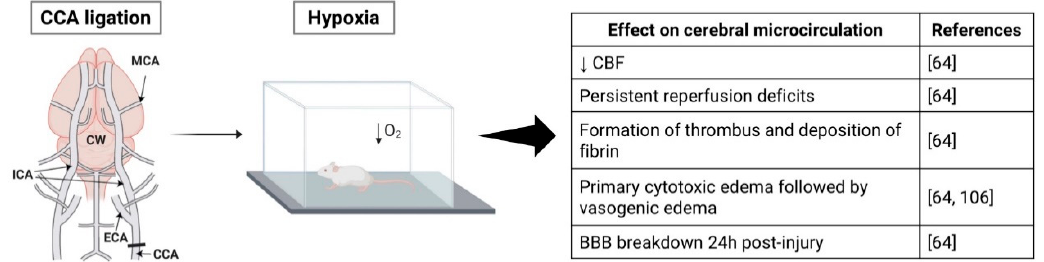
Figure 4. Schematic representation of the hypoxia-ischemia (HI) stroke model and its effects on the cerebral microcirculation. Figure created with Biorender (https://biorender.com).